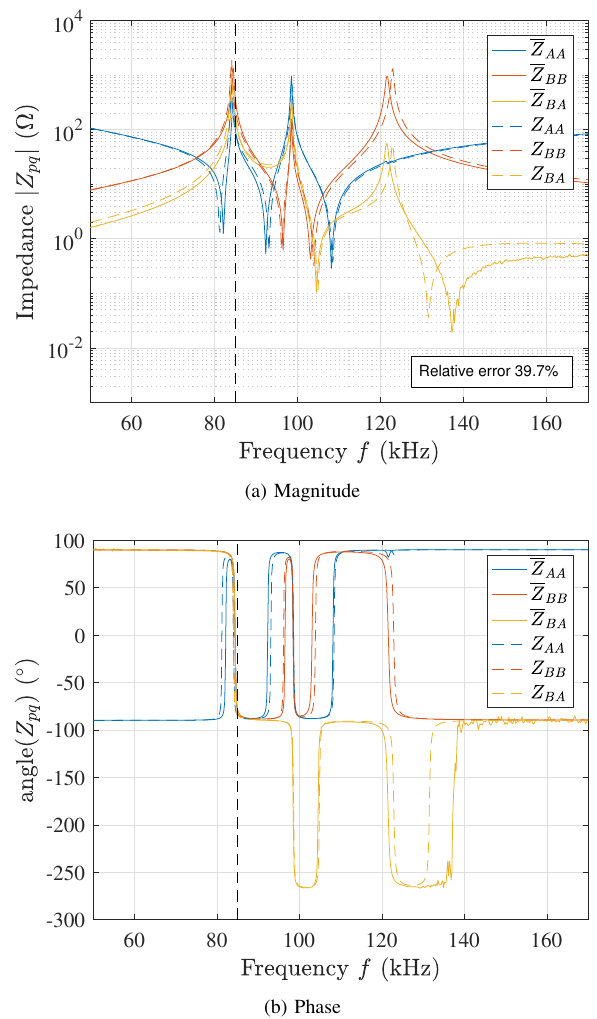
Fig. 4. Magnitude and phase of impedance matrix entries as a function of frequency: 1) solid curves – measurements Z pq ( f ν ) ; and 2) dashed curves – model Z pq ( f ν , p 0 ) for the initial parameter vector p 0 . The vertical dashed line show the operating frequency 85